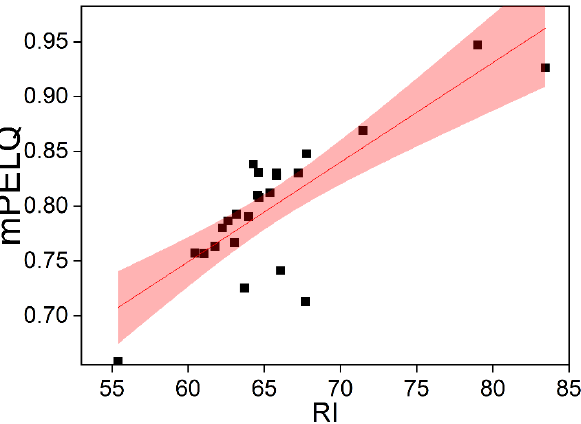
Figure 4. Correlation between the potential ecological risk index (RI) and mean PEL quotient for heavy metals in surface sediments of different stations in Zhelin Bay (R 2 = 0.81, p <